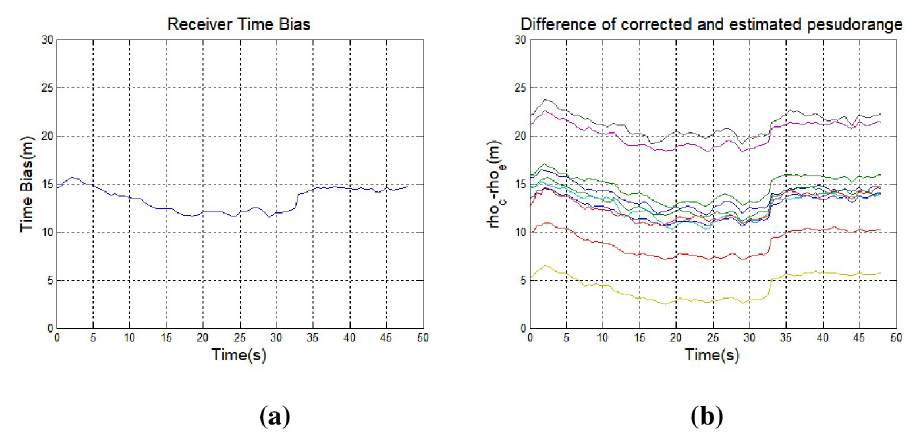
Fig 8. Measurement of receiver position during a spoofing attack with all channels subject to a 1.465-m pseudorange delay: (a) time bias and (b) difference between the corrected and estimated pseudoranges.